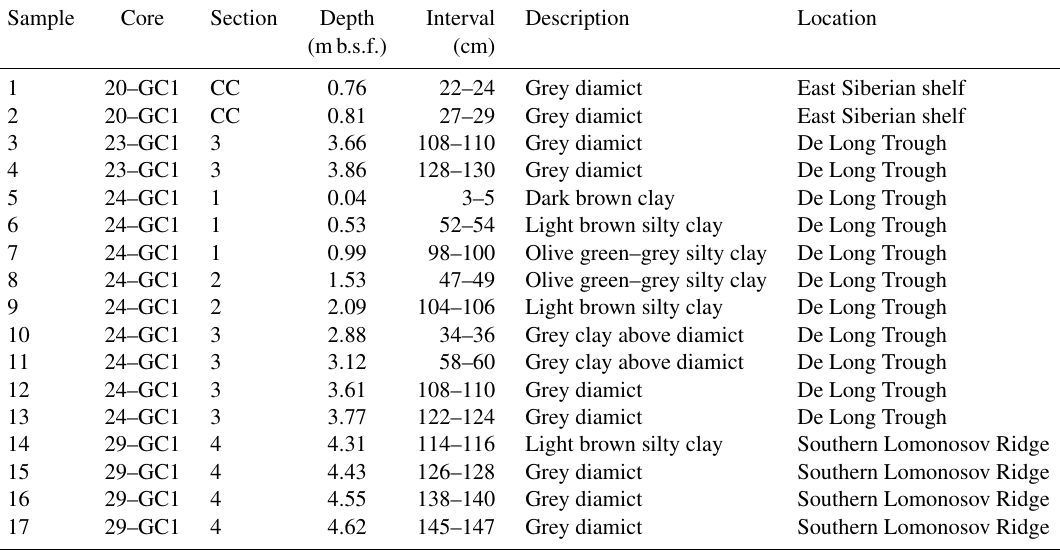
Table 3. Depth, interval (cm), and description of the 17 studied samples from cores 20-GC1, 23-GC1, 24-GC1, and 29-GC1.